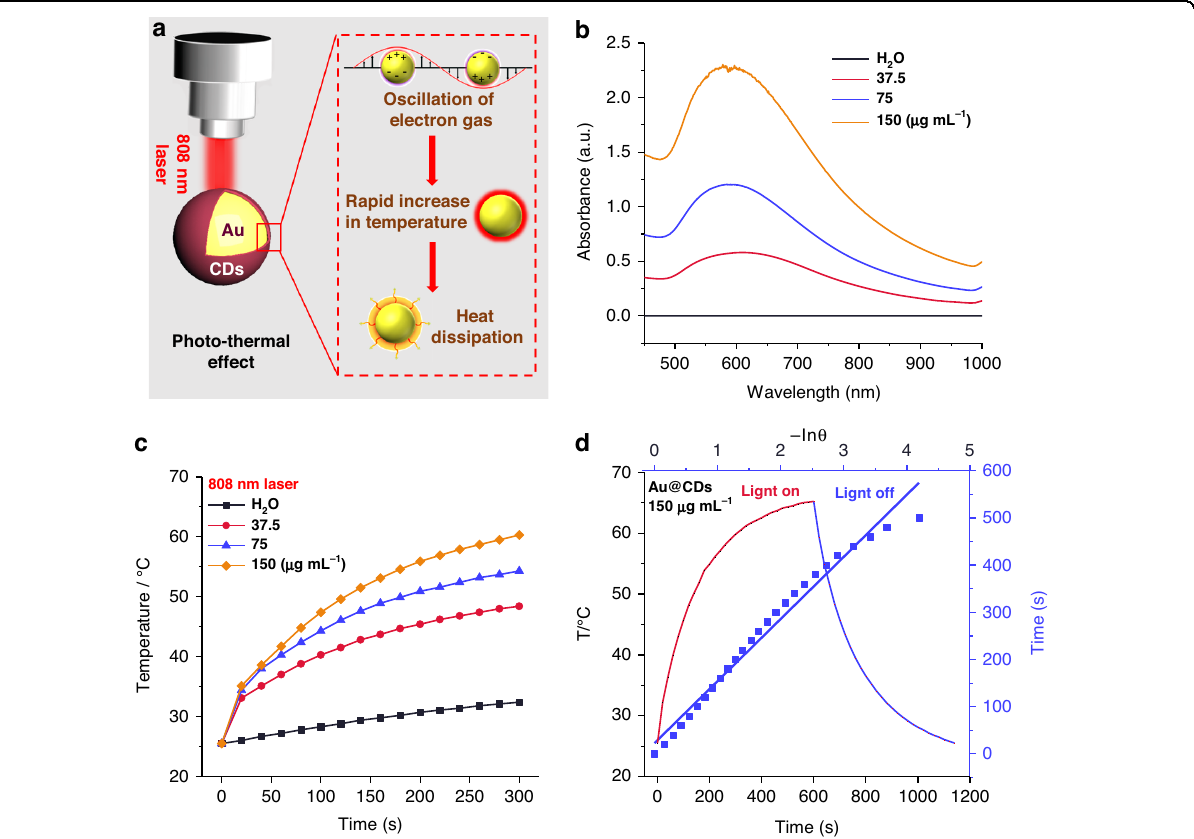
Fig. 3 Photothermal effect evaluation of Au@CDs. a Mechanism of the photo-thermal process induced by the SPR effect of Au@CDs, b vis-NIR absorbance spectra of Au@CDs in aqueous solution with varied concentrations, c the heating curves of Au@CDs under irradiation of 808 nm laser at varying concentrations in water (laser power: 2 W cm − 2), d the heating and cooling curves of Au@CDs for laser on/off and plot of cooling time versus the negative natural logarithm of the temperature driving